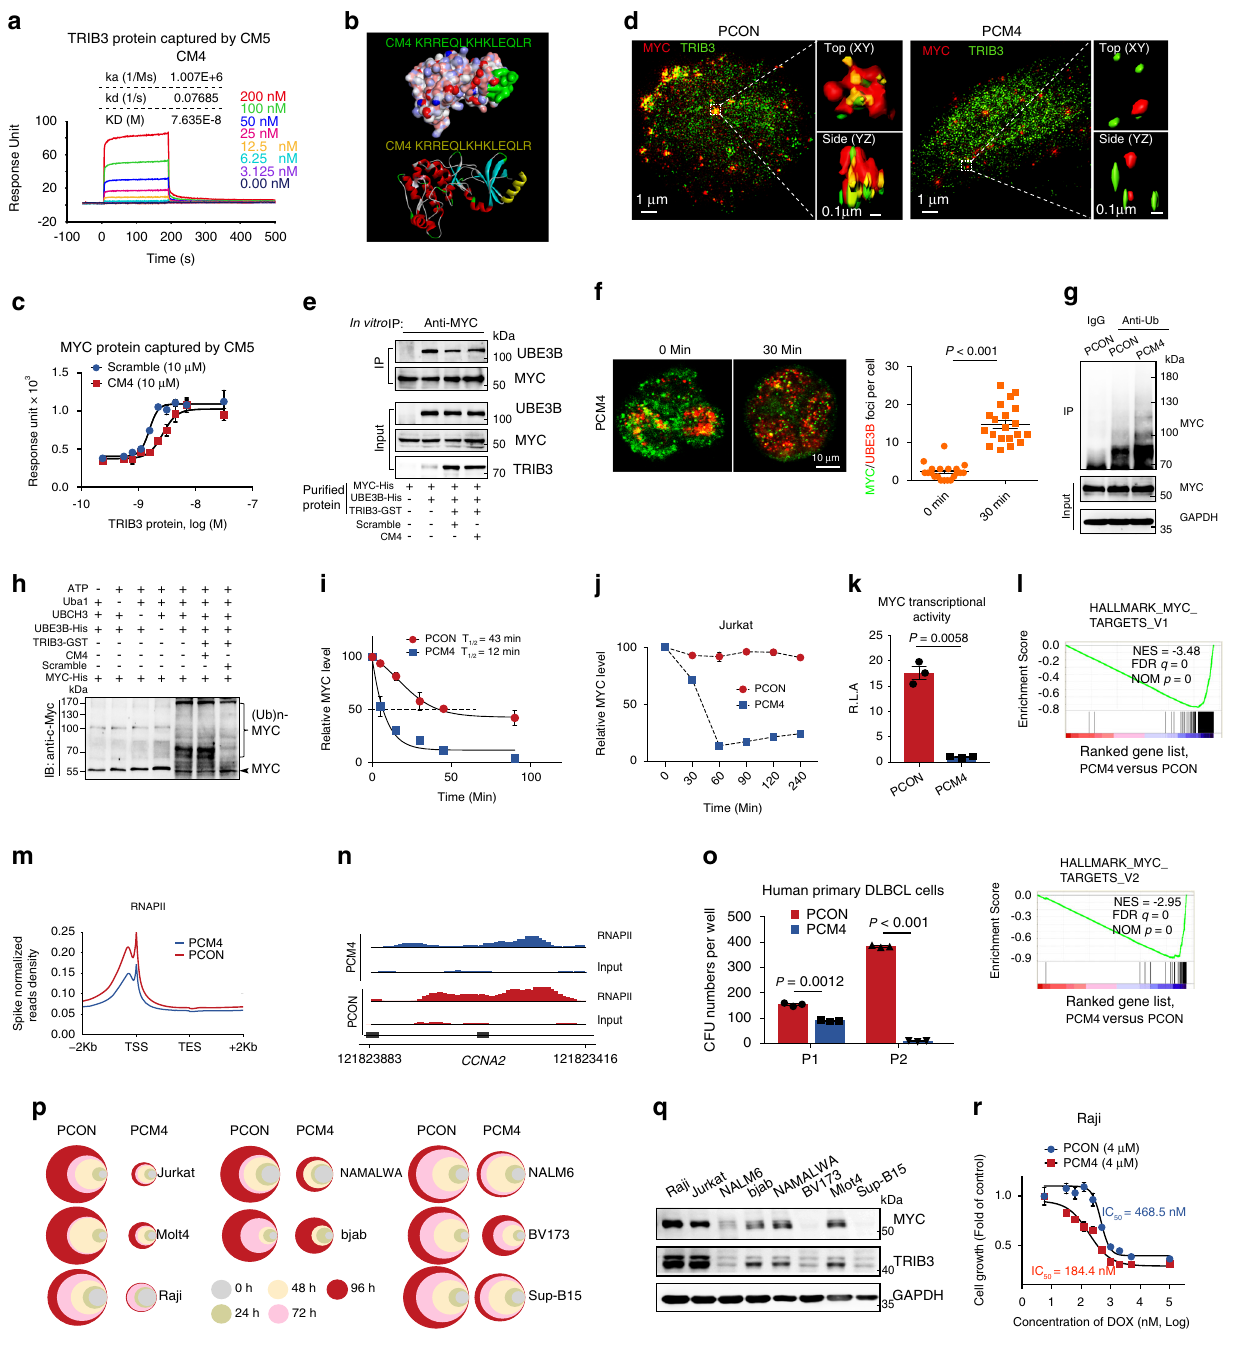
(T-LBL; T123) and TCL (T3; Fig. 8a, Supplementary Fig. 8c, and Table 1). PCM4 inhibited the tumor growth of PDXs (T64, T69, T144, T123, T174, T169, and T156) with high TRIB3 and MYC expression compared with PDXs (T151, T1, and T3) with low TRIB3 and MYC expression (Fig. 8b – h). The combination of PCM4 and DOX further decreased the growth and weights of tumors in PDX mice with high TRIB3 and MYC expression (Fig. 8b – i). In comparison with the benign LN tissues, most lymphoma specimens showed high expression of TRIB3 but not UBE3B (Fig. 8j and Supplementary Fig. 8d). Notably, a positive correlation was observed between TRIB3 and MYC expression (Fig. 8k, l). These data indicate that TRIB3 plays a critical role